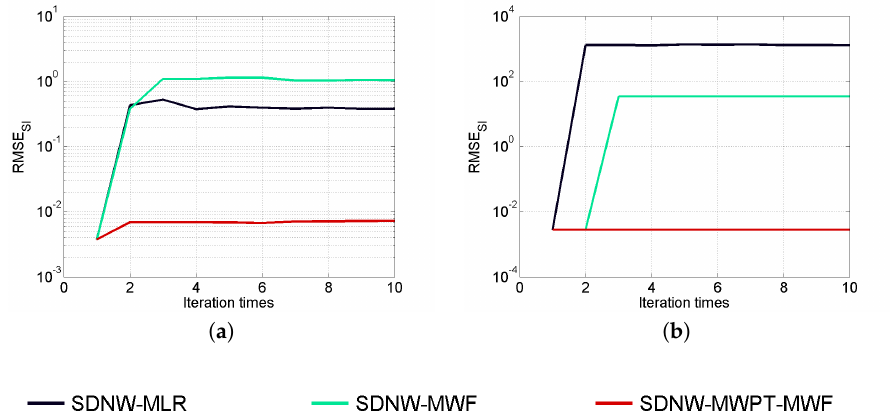
Figure 5. Evolution of RMSE SI with iteration times according to different values of SNR INPUT : ( a ) 20 dB; ( b ) 40